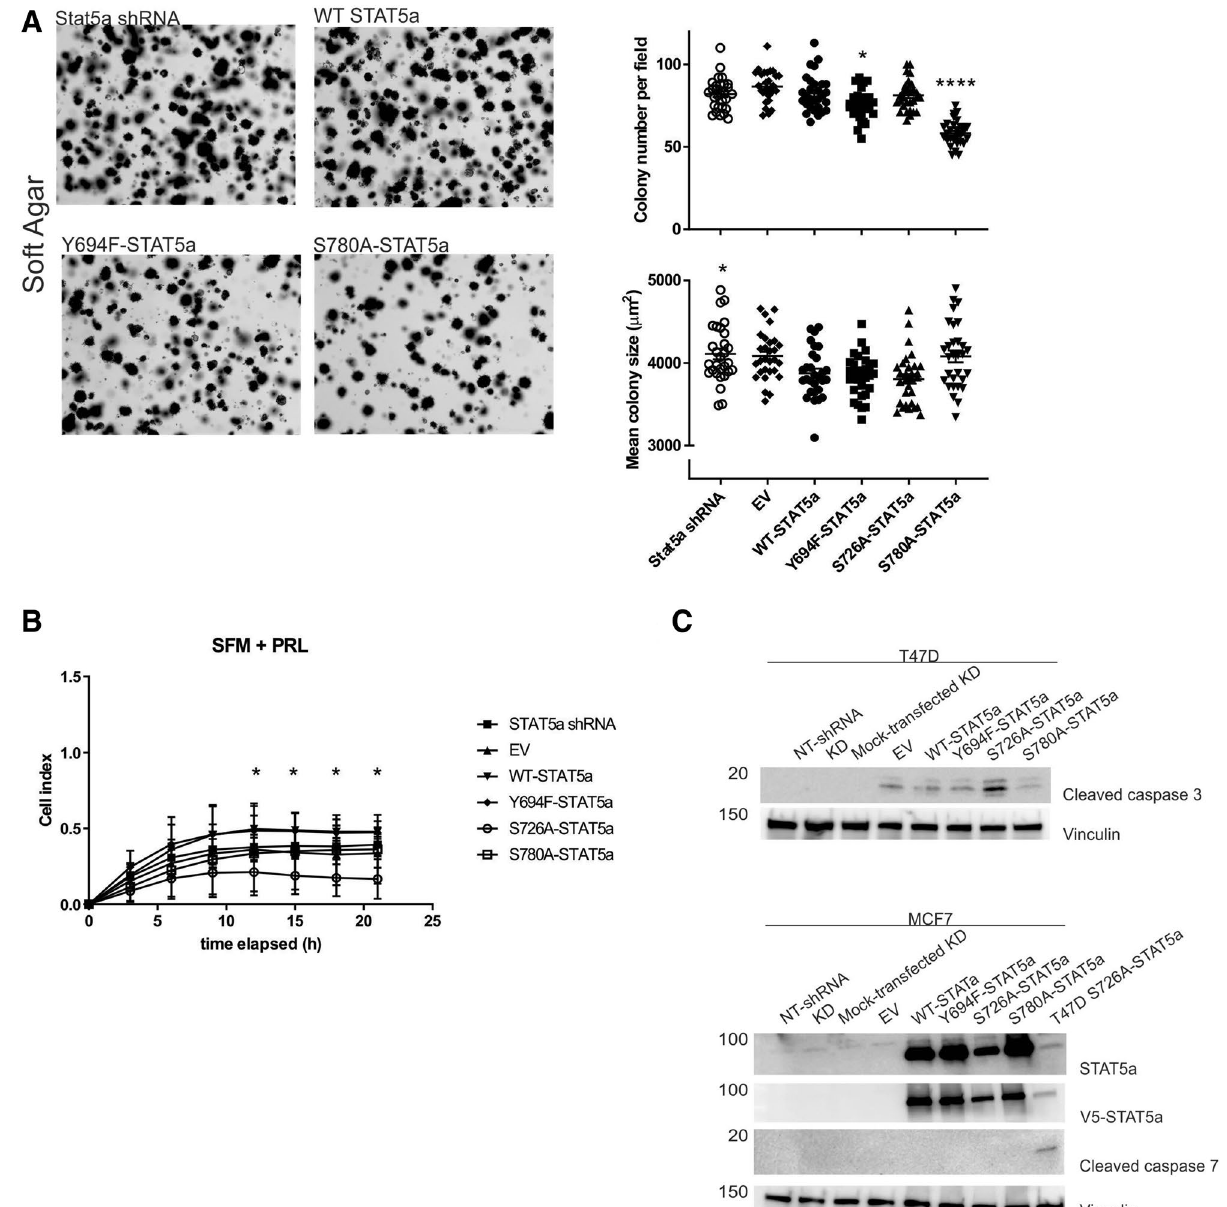
Figure 4. Effect of single-point phospho-deficient STAT5a mutants on characteristics of MCF7 cells. ( A ) Representative images and quantification of number and size of the colonies formed in soft agar by indicated MCF7 cells with knockdown (KD) of STAT5a rescued by phospho-deficient mutants. n = 3, * p < 0.02 compared to WT-STAT5a. ( B ) Proliferation in serum-free media (SFM) supplemented with PRL was assessed using XCELLigence, cell index indicates proliferation. n = 3, p < 0.02 compared to WT-STAT5a. ( C ) Immunoblots of T47D cells (top) and MCF7 (bottom) cells carrying transient rescues of STAT5a point mutants assessed for apoptosis by expression of cleaved caspase 3 or 7. Graphs and statistics generated in GraphPad Prism 9.0.0 for Windows (GraphPad Software, San Diego, California USA, www. graph pad.